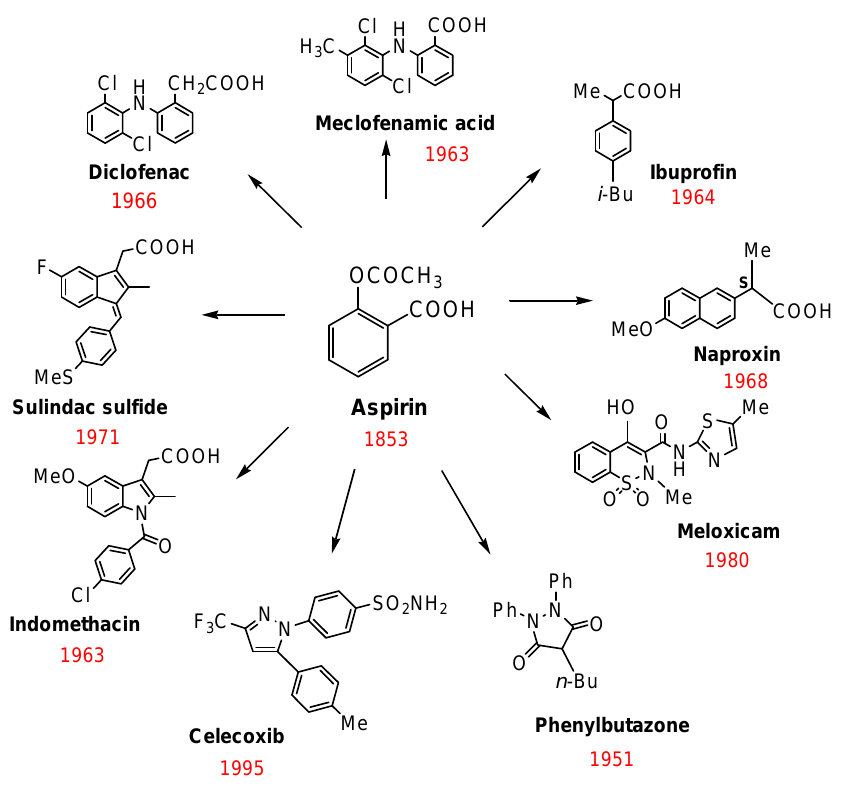
Figure 1. Chemical structures of commonly used